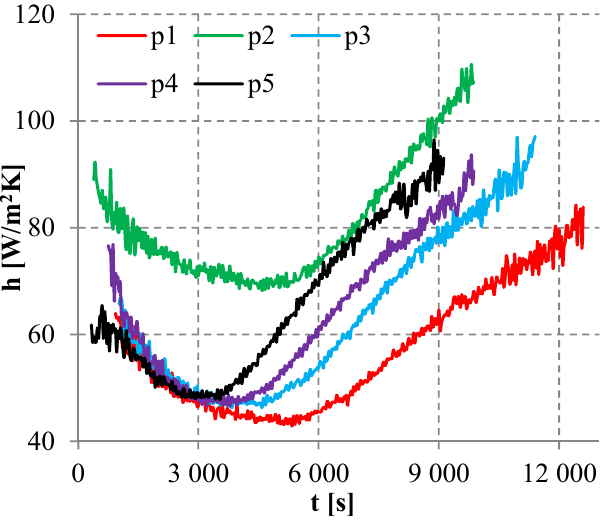
Figure 5. Mean values of HTC on the cylinder boundary (for planes A1–A4) for processes p1–p5. Differences between values of temperature and HTC on the cylinder boundary in planes A1, A2, A3 and A4 and respective mean values were considered. To do so, for- mulae for the absolute difference of temperature (for time t k , k = 0, 1, 2, …, N) ∆T (cid:2885)(cid:2919) (t (cid:2921) ) = T (cid:2885)(cid:2919) (t (cid:2921) ) − T(cid:3365)(t (cid:2921) ) (10) and of HTC (for time t k , k = 0, 1, 2, …, N) ∆h (cid:2885)(cid:2919) (t (cid:2921) ) = h (cid:2885)(cid:2919) (t (cid:2921) ) − h(cid:3364)(t (cid:2921) ) (11) were used, where i = 1, 2, 3, 4. The relative differences for temperature (for time t k , k = 0, 1, 2, …, N)